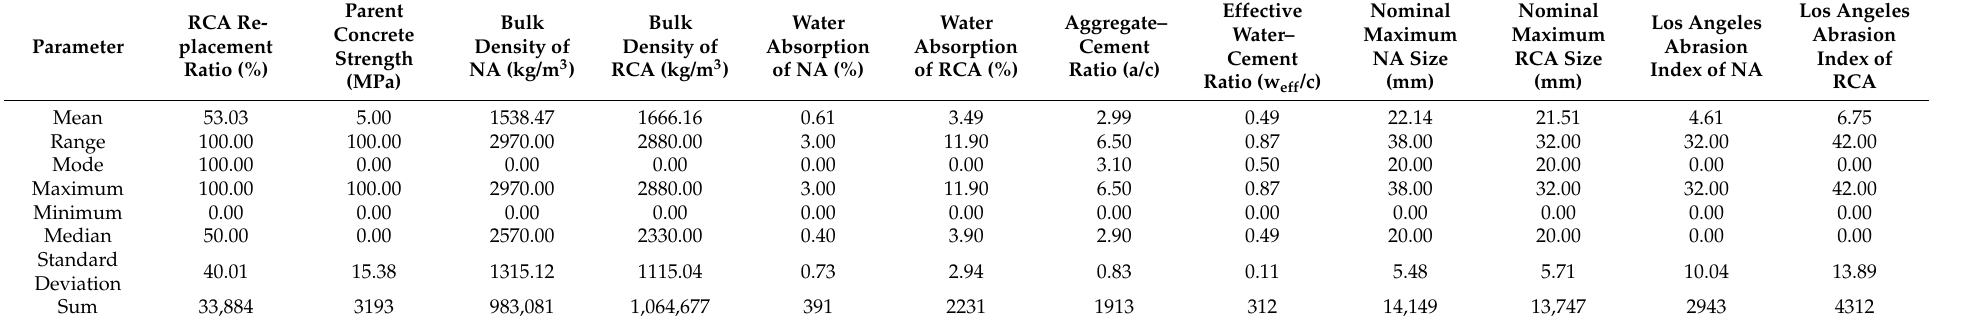
Table 1. Descriptive statistical values of input factors for the compressive strength dataset.